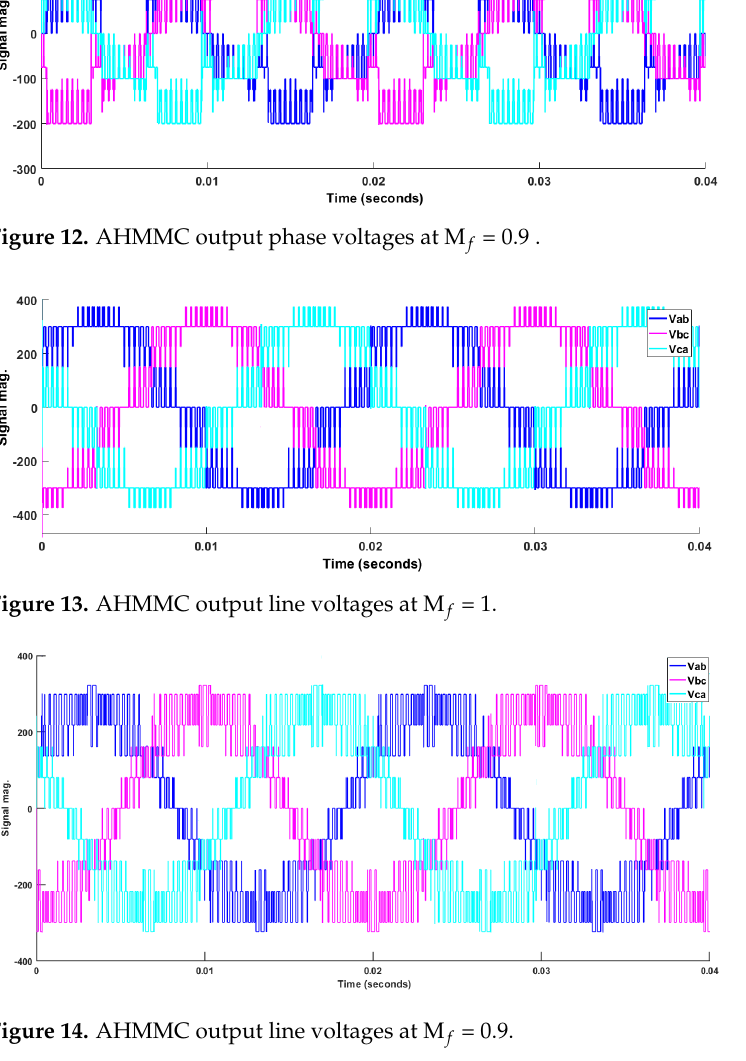
Figure 14. AHMMC output line voltages at M f =